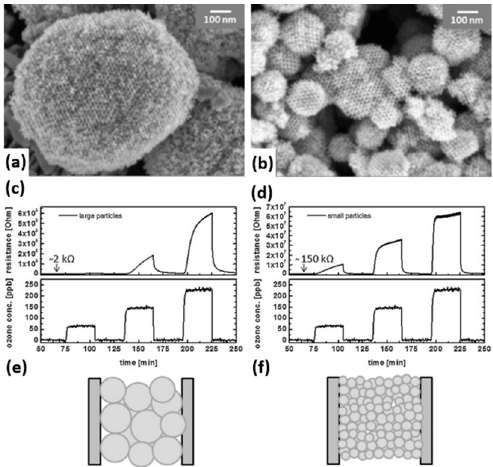
Figure 41. Response towards 5 ppm NO 2 in dry synthetic air with UV light irradiation at different temperatures of the non-structured ( black ) and the mesoporous In 2 O 3 ( gray ). Reproduced with permission from [68].